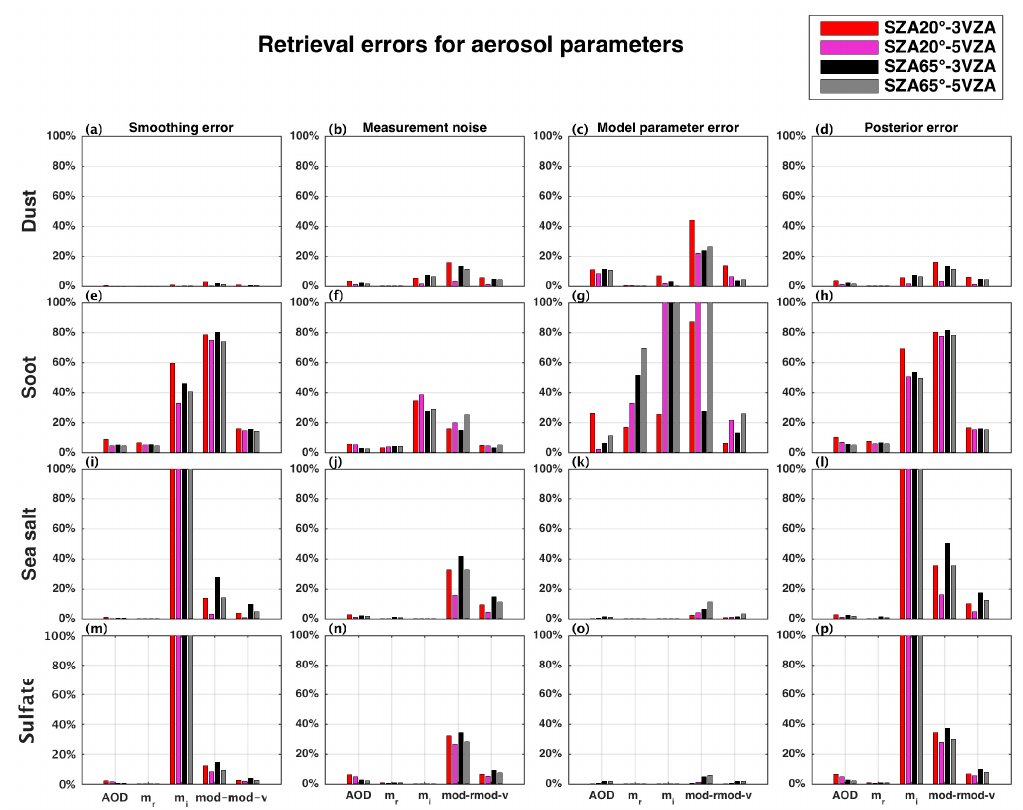
Figure 6. Four kinds of retrieval errors for multi-angle retrieval in three viewing angles and five viewing angles respectively. Others are the same as Figure 4.